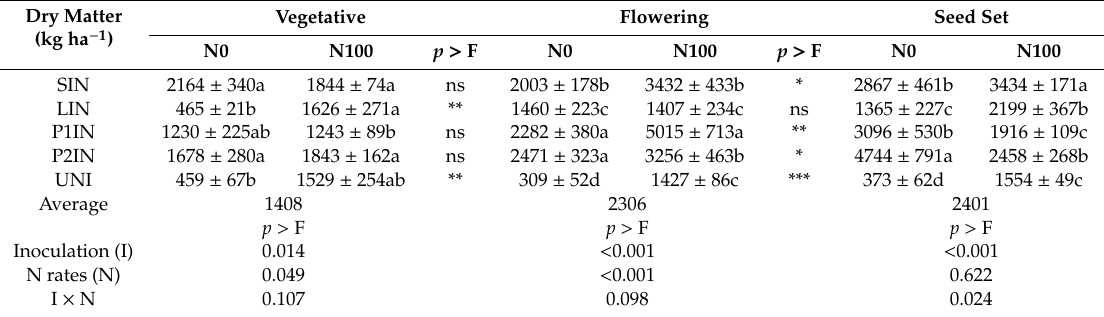
Table 2. Average ( ± standard error) leaf dry matter yield (kg ha − 1 ).